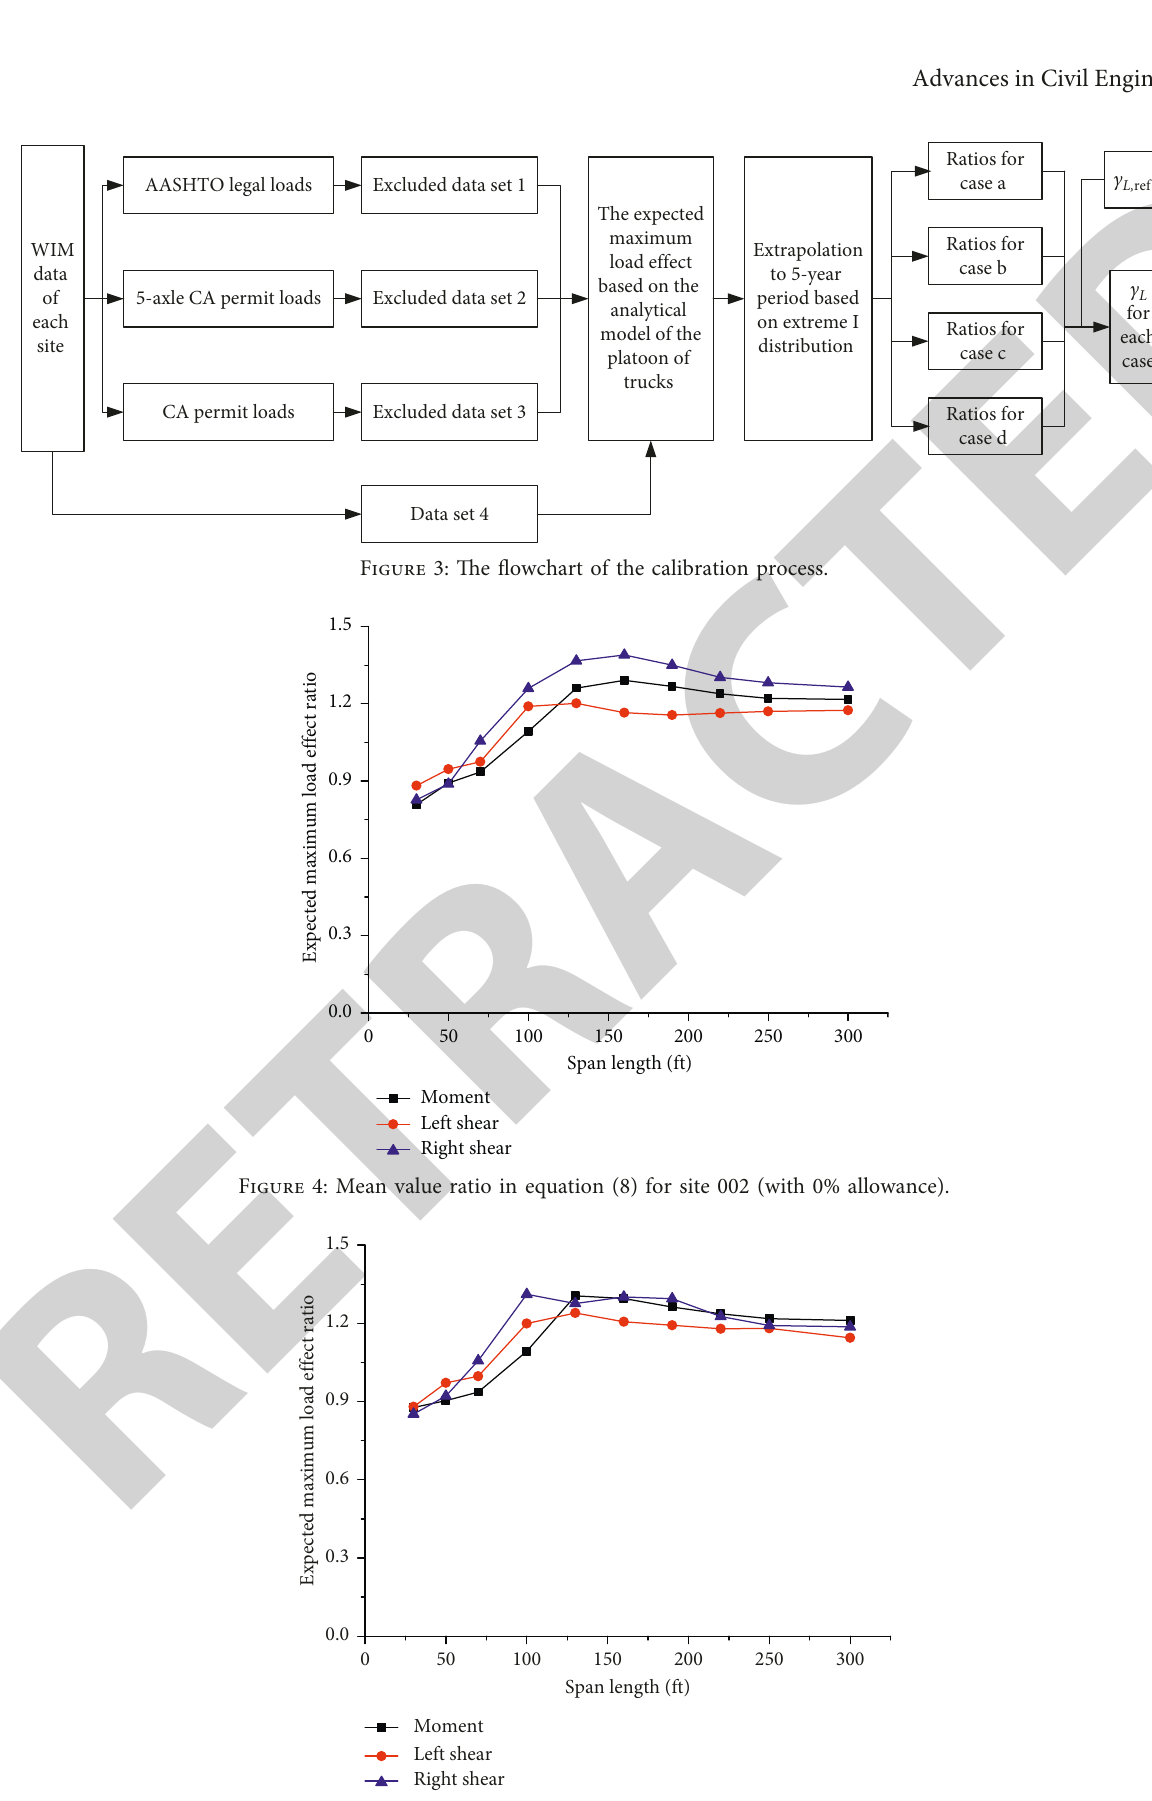
Figure 5: Mean value ratio in equation (8) for site 002 (with 10%